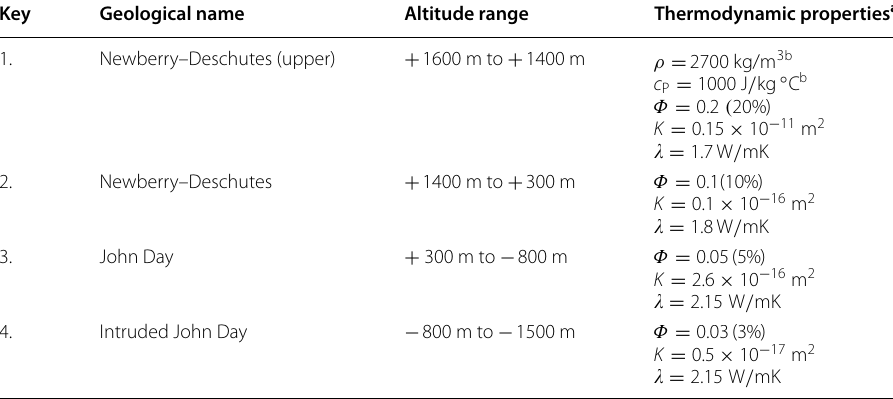
Table 4 Key geological settings in support of Fig. 2 (left)